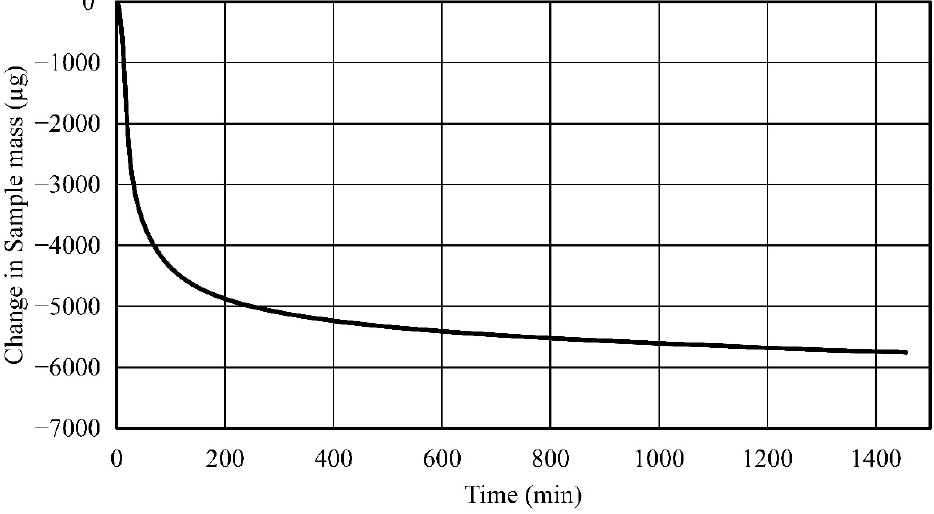
Figure 6. Thermogravimetric analysis of the neat polymer